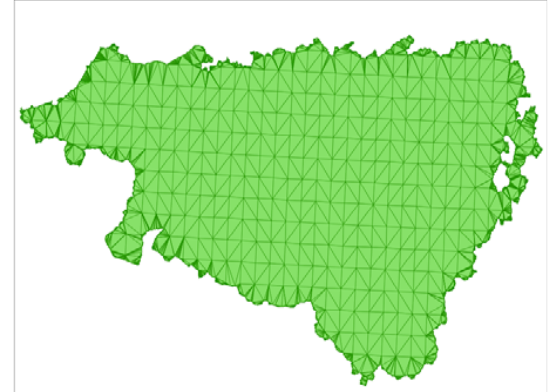
Figure 10: Spherical triangles used to estimate the true area of Pyrénées-Atlantiques using geodetic (ellipsoidal) calculations. (From Girres, 2012, p. 117)